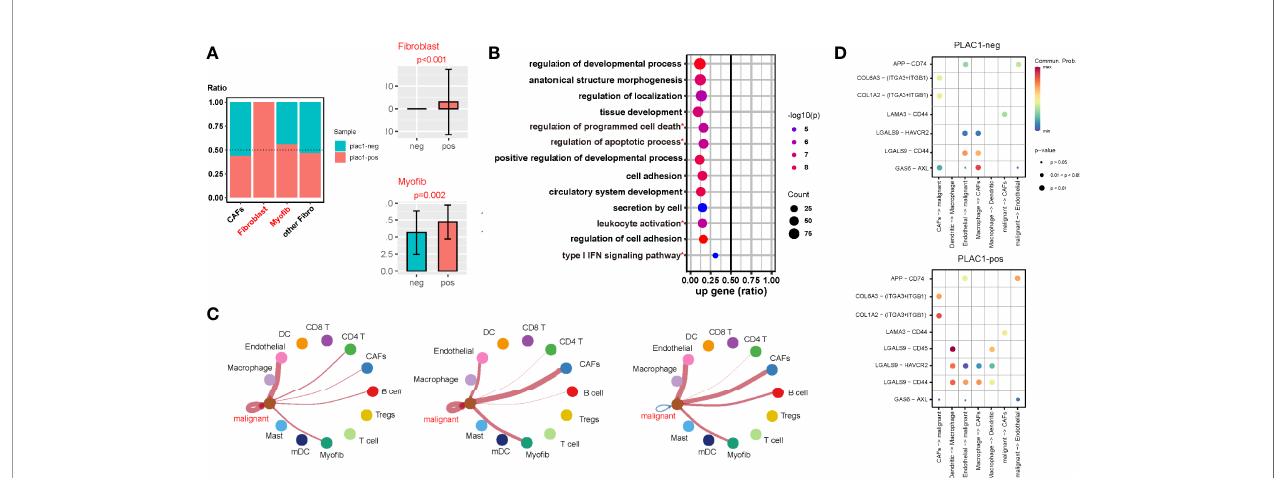
FIGURE 4 | Plac1 shapes a nonin fl amed tumor microenvironment (TME) in head and neck squamous cell carcinoma. (A) Differences in the fi brotic component proportion of the TME of plac1-positive and plac1-negative samples. (B) Kyoto Encyclopedia of Genes and Genomes pathway analysis of fi broblasts between plac1- positive and plac1-negative samples. (C) Differences in the cell – cell interaction of plac1-positive and plac1-negative cells with other cells in the TME. The left panel represents cell – cell contact, the middle panel represents extracellular matrix – receptor interaction, and the right panel represents secreted signaling. (D) Differences in the interaction strength of speci fi c ligand – receptor pairs between plac1-positive and plac1-negative samples. *Pathways that are concerened in further